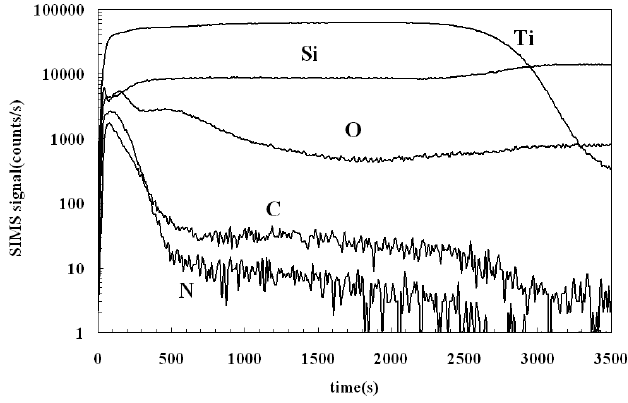
Figure 9. SIMS depth profiles of Ti films, 500 nm thick, heated at 800 °C and processed in (Ar ‐ 33%N 2 ‐ 1%H 2 ) plasma for 1 h.